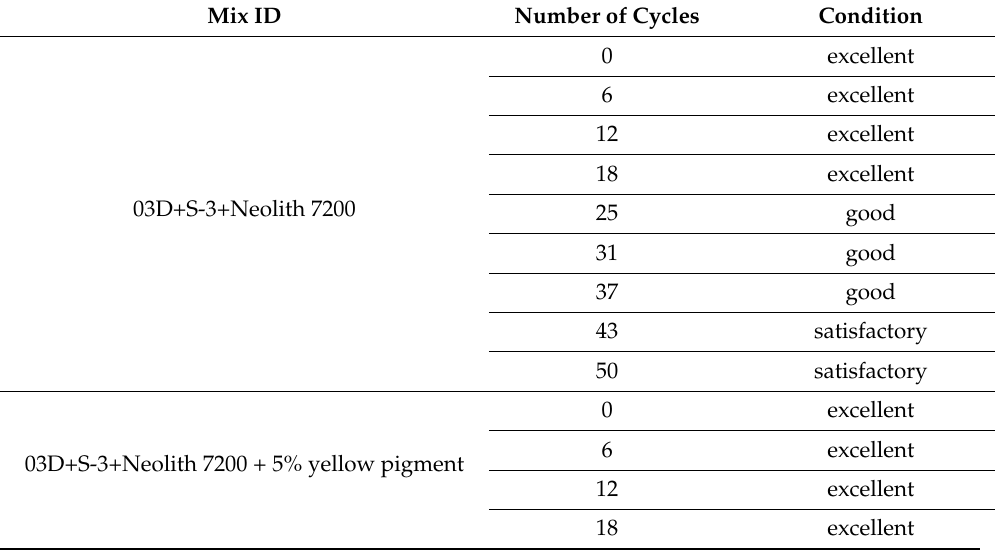
Table 13. Quality of the appearance of painted